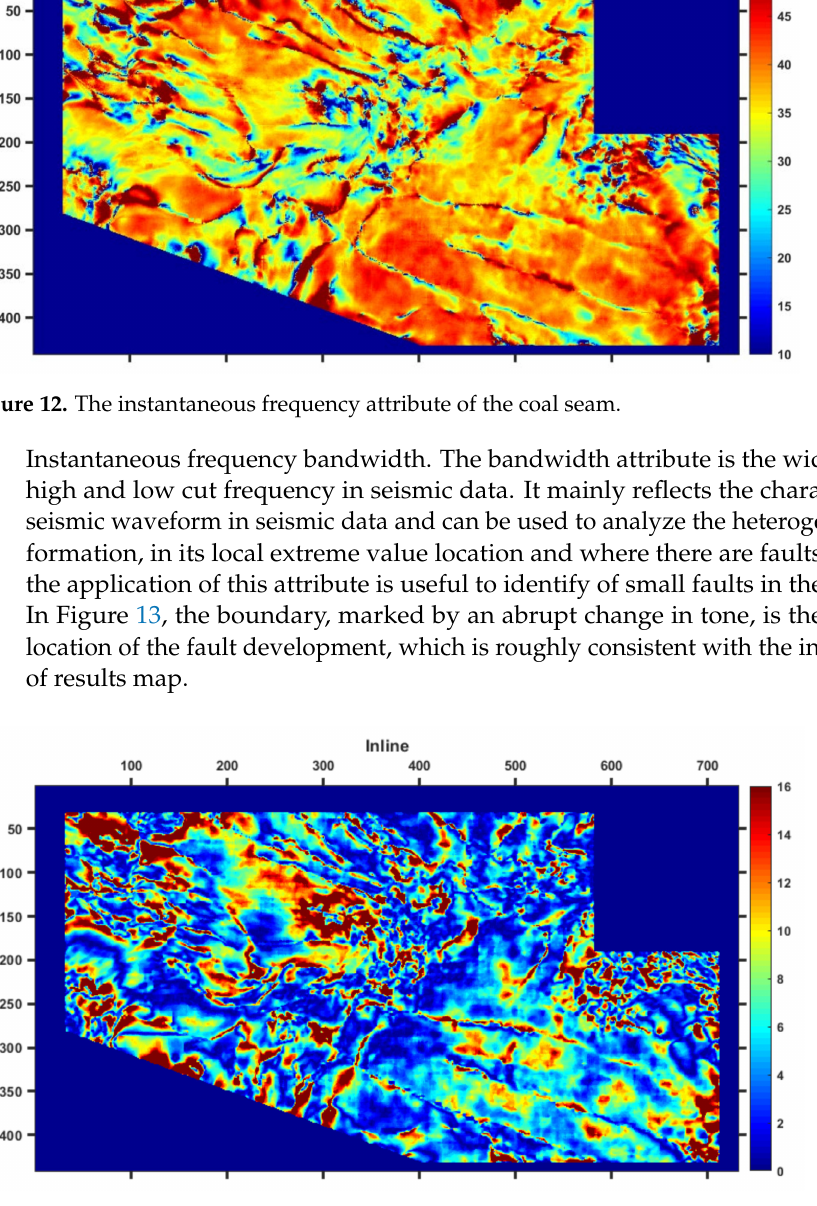
Figure 13. The frequency bandwidth attribute of the coal seam. 5. Attenuation coefficient. The attenuation coefficient is an important parameter to describe geological body anomaly. In the subsurface of non-uniform geological bodies with different attenuation coefficients, the seismic reflection wave has different response characteristics under the condition of energy attenuation. There is a fault at the local minimum of the attenuation coefficient. When the fault drop is small, attenuation coefficient correspond essentially to the fault location in the interpretation map, but the characterization of small structures is not